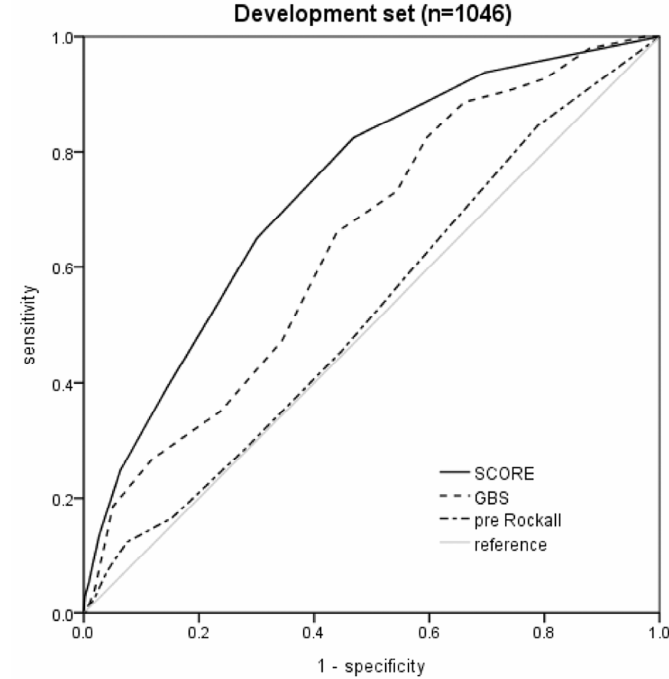
Figure 2. Comparison of the predictive ability of the new score with that of the GBS and the pre-endoscopy Rockall score in predicting the occurrence of hypotension in the development set. GBS, Glasgow–Blatchford score.